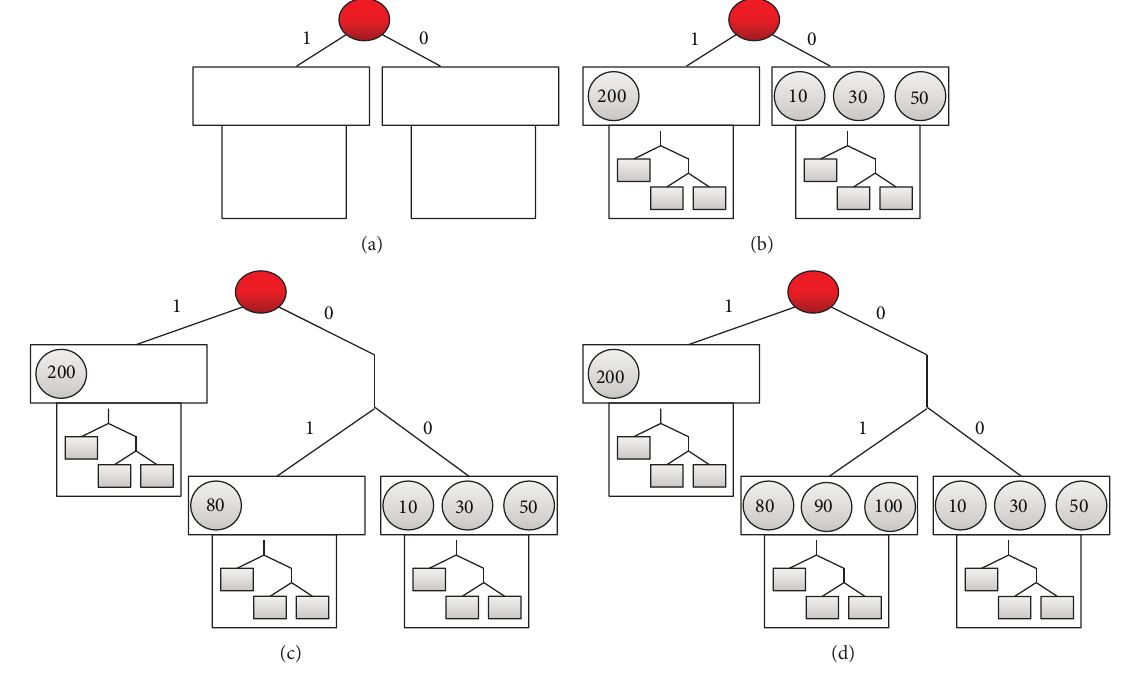
Figure 4: A construction example of PR